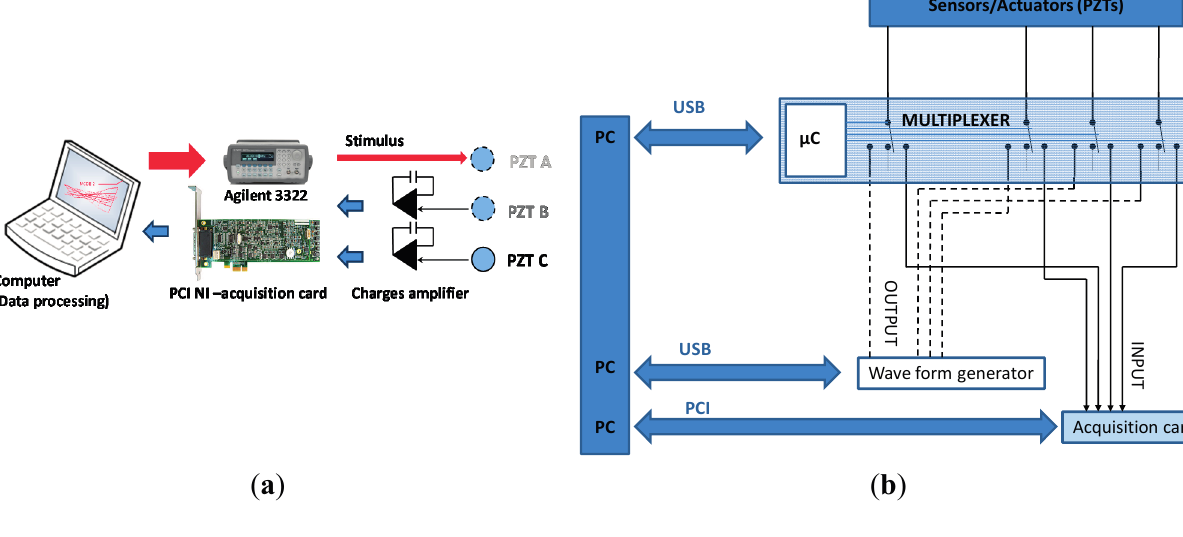
Figure 15. ( a ) Schematic of the experimental setup: The stimulus is generated by PZT A-1 and received by PZT B-2 and C-3. The data is recorded using a NI acquisition card at a rate of 2.5 Msamples/s; ( b ) Detailed synoptic of the experimental setup; ( c ) Pitch catch